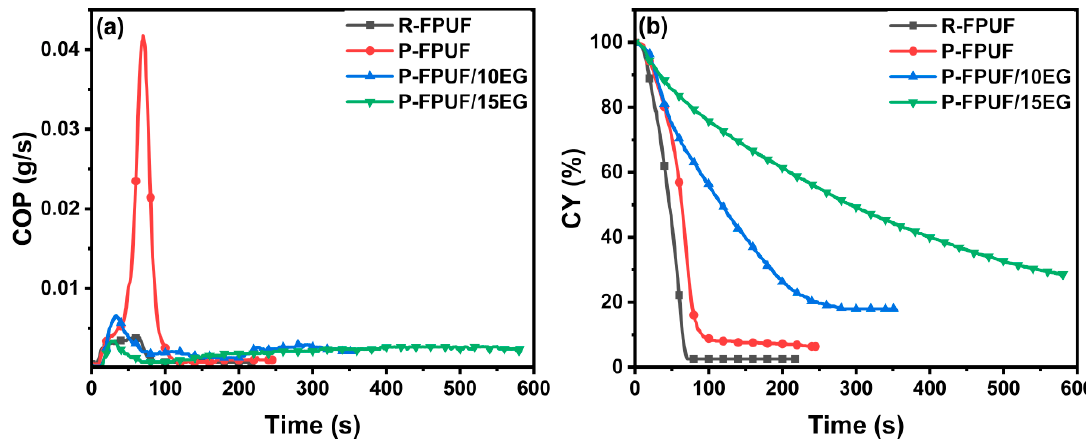
Figure 7. Carbon monoxide production ( a ) and char yields ( b ) curves for FPUFs.